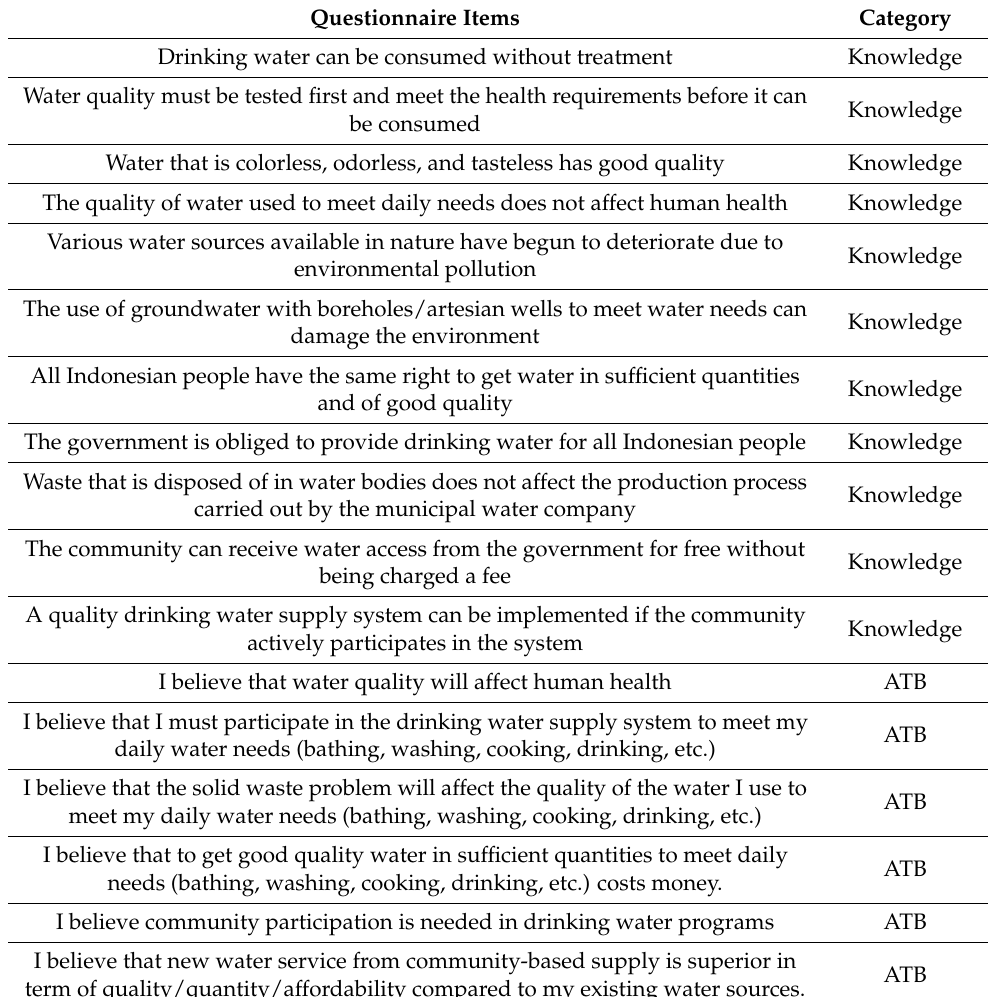
Table A1. Key questions related to knowledge and components of the TPB